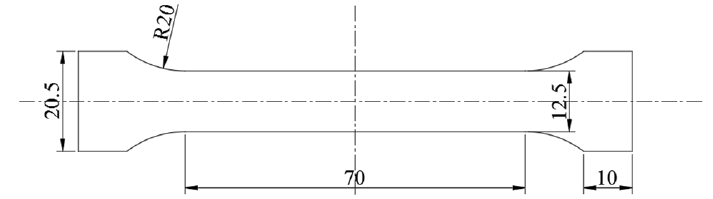
Figure 1. Schematic of the tensile sample (in mm).